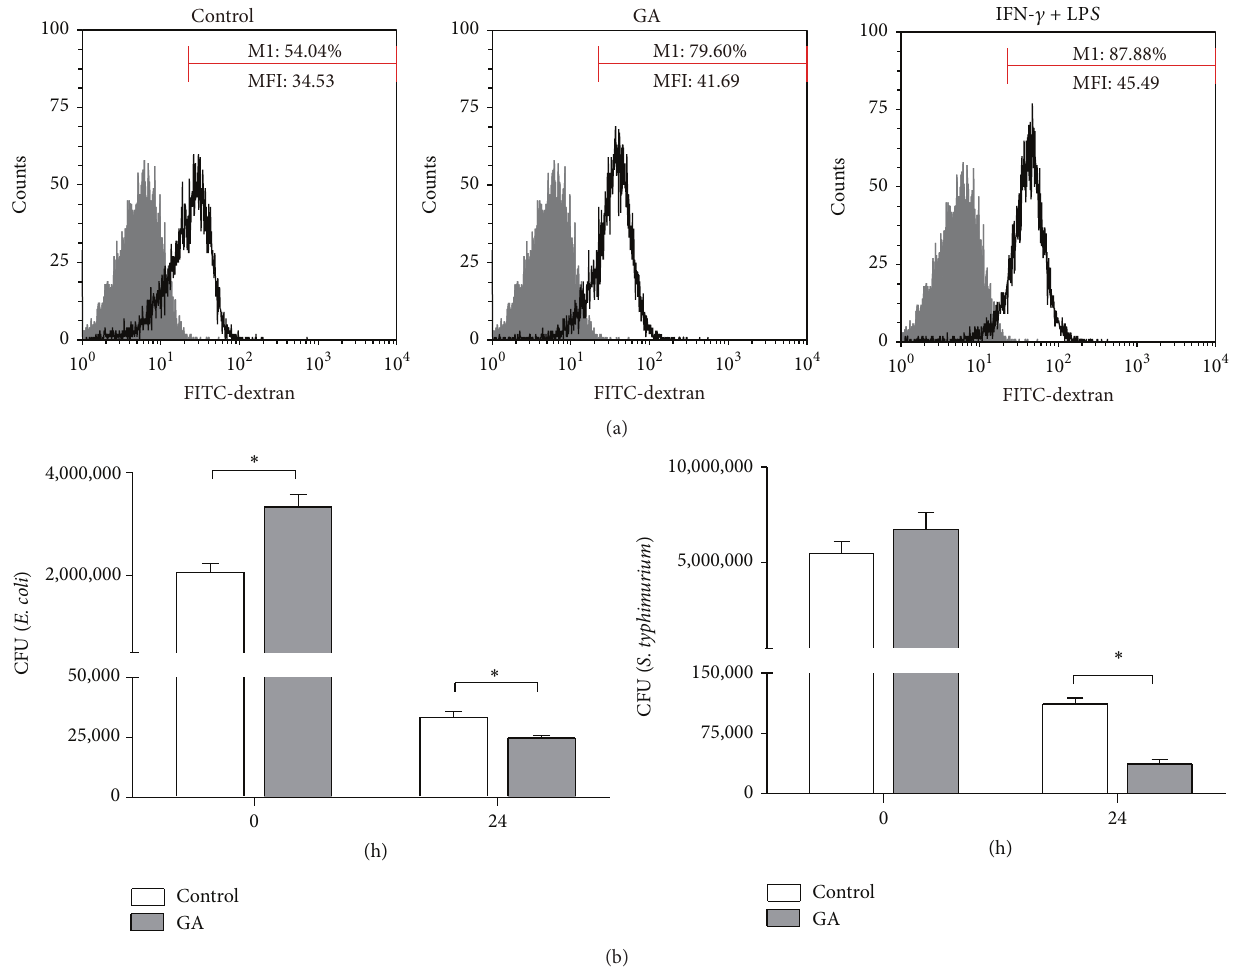
Figure 6: Effect of GA on BMDMs phagocytosis and bactericidal activity. BMDMs were pretreated with GA (100 𝜇 g/mL) for 12h. (a) Incubated with FITC-dextran at 37 ∘ C for 1h, the intracellular FITC-dextran was measured by FACS. (b) After being infected with E. coli K88 or S. typhimurium for 1h, washed, and incubated in DMEM with gentamicin (25 𝜇 g/mL) for 0h or 24 h, these cells were lysed, diluted, and plated on LB plates for colony enumeration. Data are mean ± SD for three independent experiments. ∗ 𝑃 < 0.05 ( 𝑡